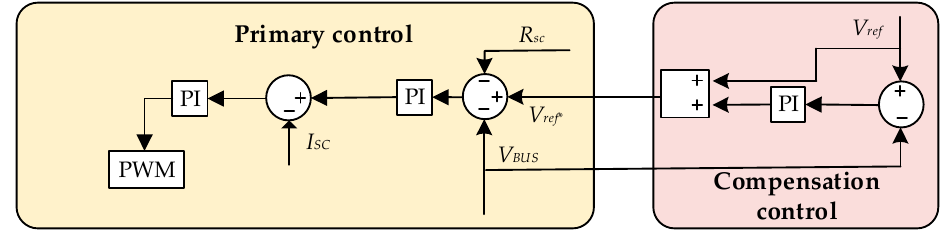
Figure 5. Structure of the compensation control.